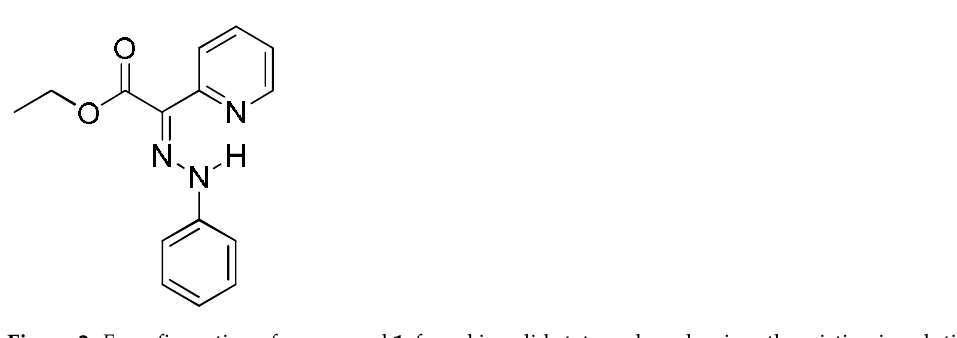
Figure 2. E- configuration of compound 1 , found in solid state and predominantly existing in solution.